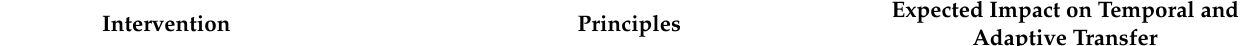
Table 6. Refresher interventions for complex cognitive tasks and their impacts on temporal and adaptive transfer.